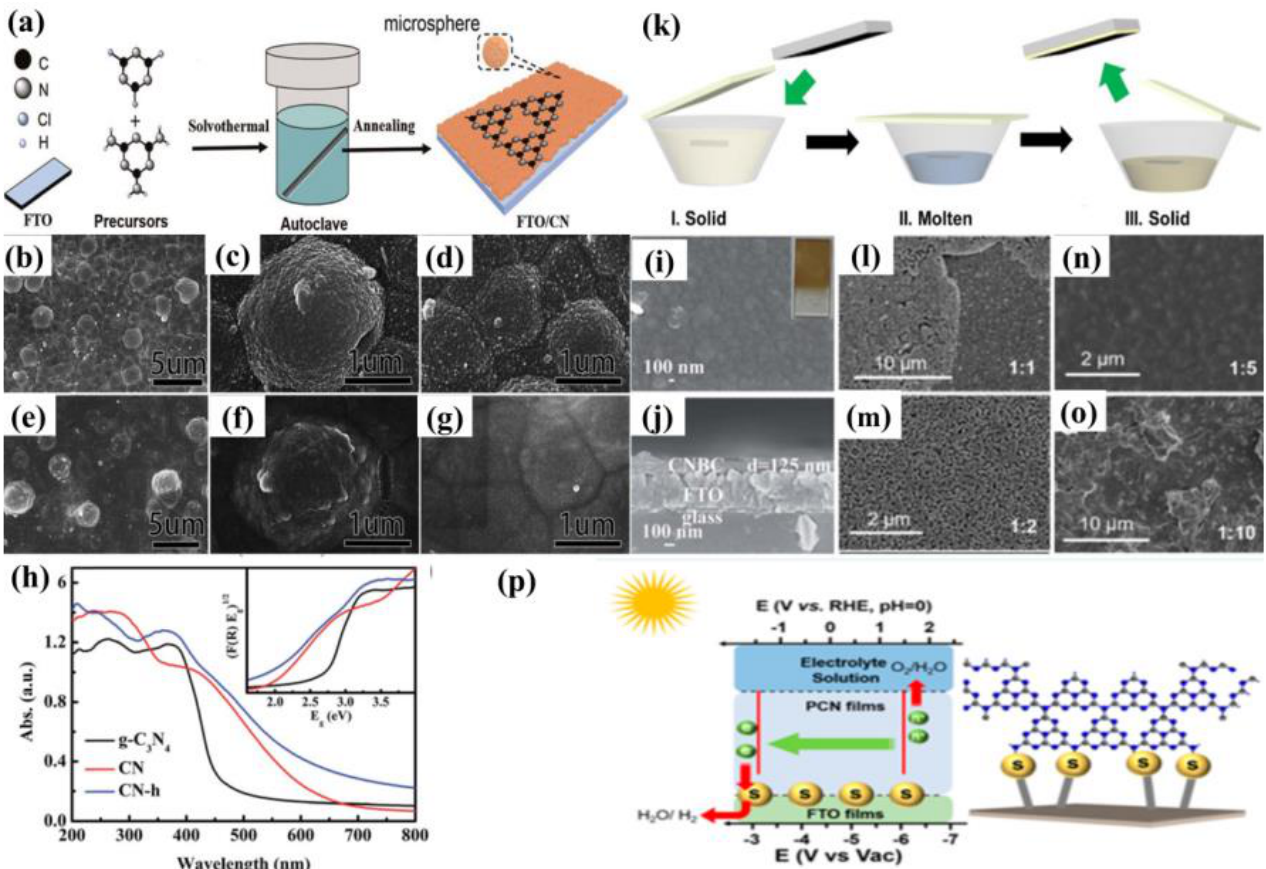
Figure 6. ( a ) Schematic illustration of the solvothermal synthesis route. Solvothermal approach utilizing melamine and cyanuric chloride: SEM images of ( b – d ) g − CN sample before annealing and ( e – g ) g − CN sample after annealing and ( h ) UV-vis absorption spectra (the inset shows the Tauc plots). Reprinted with permission from ref. [57] Copyright 2016 Royal Society of Chemistry. Solvothermal approach using cyanuric chloride and cyanuric acid: SEM images of the top view ( i ) and cross-section ( j ) of annealed g − CN thin film (the inset is the digital image). Reprinted with permission from ref. [58] Copyright 2017 Royal Society of Chemistry. ( k ) Liquid mediated growth mechanism, ( l – o ) SEM images of the structured PCN films with different molar ratios (the mixture of melamine and trithiocyanuric acid) after condensation at 500 °C for 4 h, and ( p ) the growth mechanism of the PCN films by combination of sulfur and non-sulfur mixtures and mechanism for water splitting. Reprinted with permission from ref. [59] Copyright 2014 American Chemical Society.